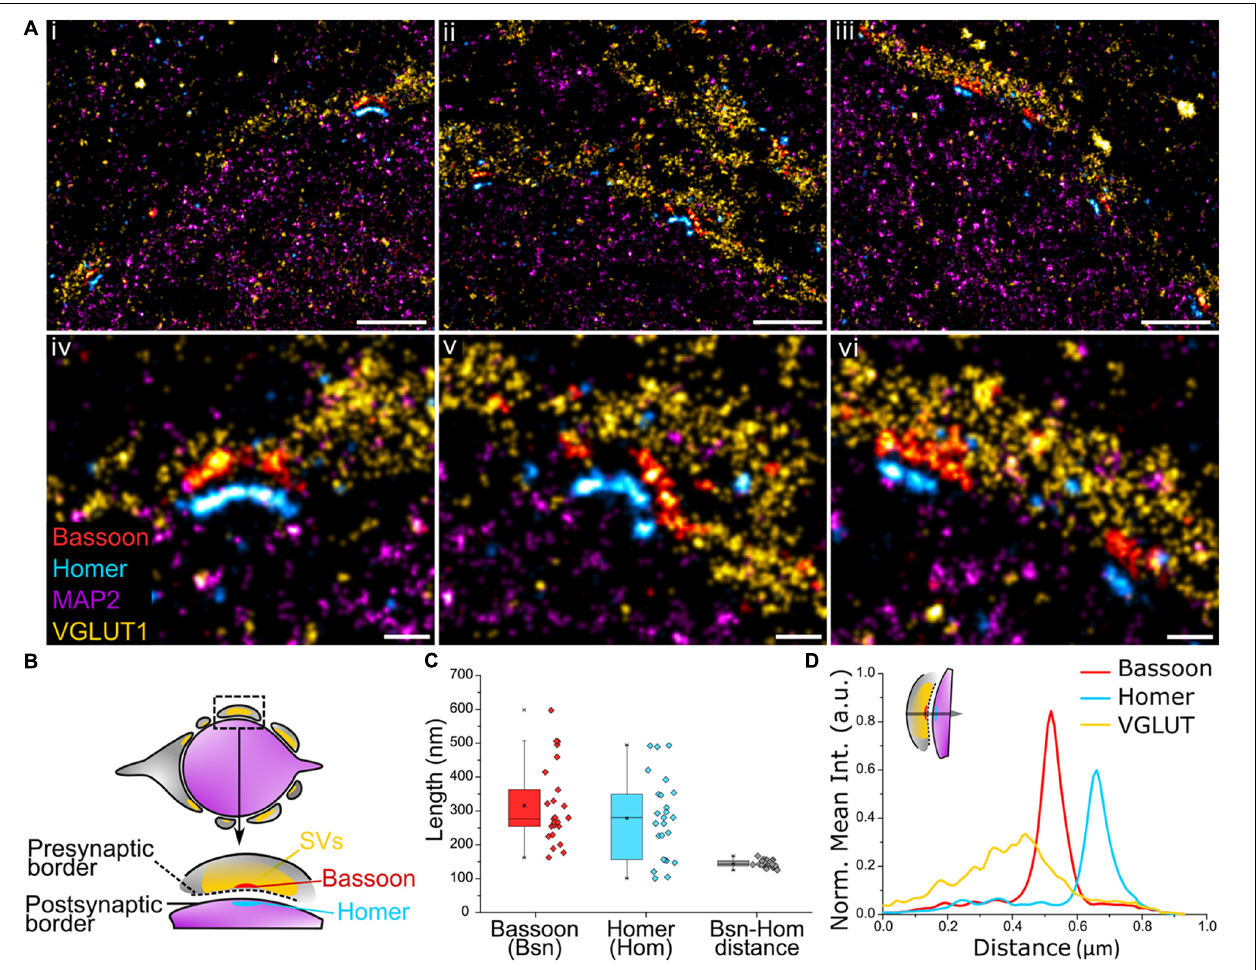
FIGURE 4 | (A) Four-target images of (i–iii) the organization of multiple Bassoon and Homer structures sandwiched between VGLUT1 (SV) and MAP2 (microtubules) along the presynaptic border of the calyx of Held and the postsynaptic border of the principal cell. (iv–vi) Magnification of the AZ-PSD interface with aligned Bassoon and Homer structures showing linear or curved morphologies. (B) Graphical representation of a trans-section of a calyx of Held principal cell (purple) surrounded by the presynaptic cell (gray) and the organization of Bassoon, Homer, and SVs. (C) Quantification of the length of Bassoon- or Homer-positive areas, and the distance between Bassoon and Homer; n = 25. (D) Line profile of 2D spatial organization of protein density based on fluorescence intensity from VGLUT1 to Bassoon to Homer; n = 16. Scale bar 1 µ m (i–iii) and 0.2 µ m (iv–vi)